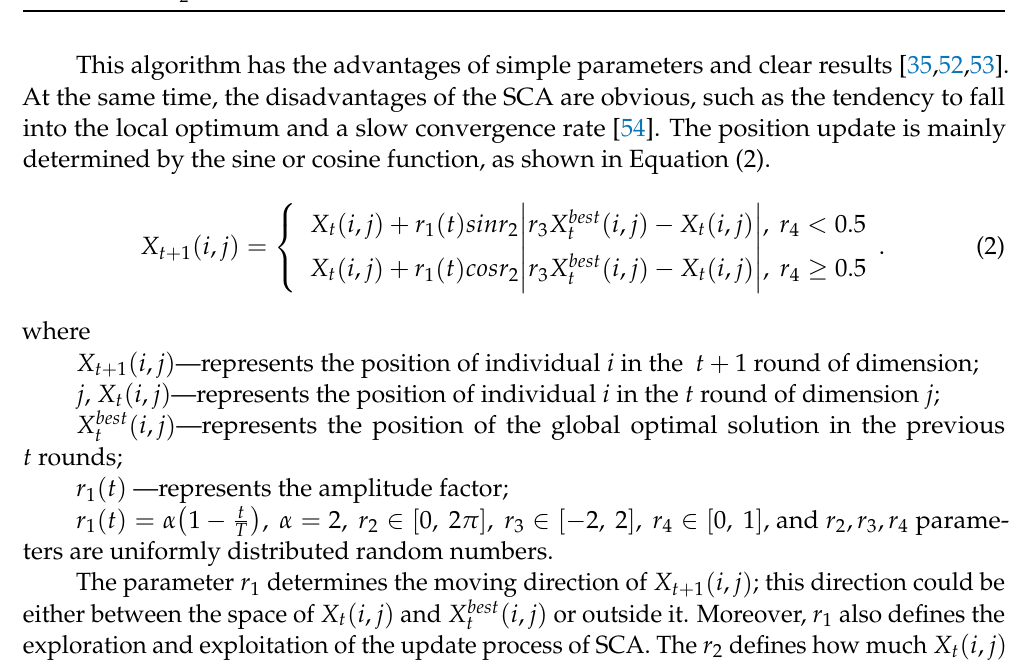
Golden section coefficient